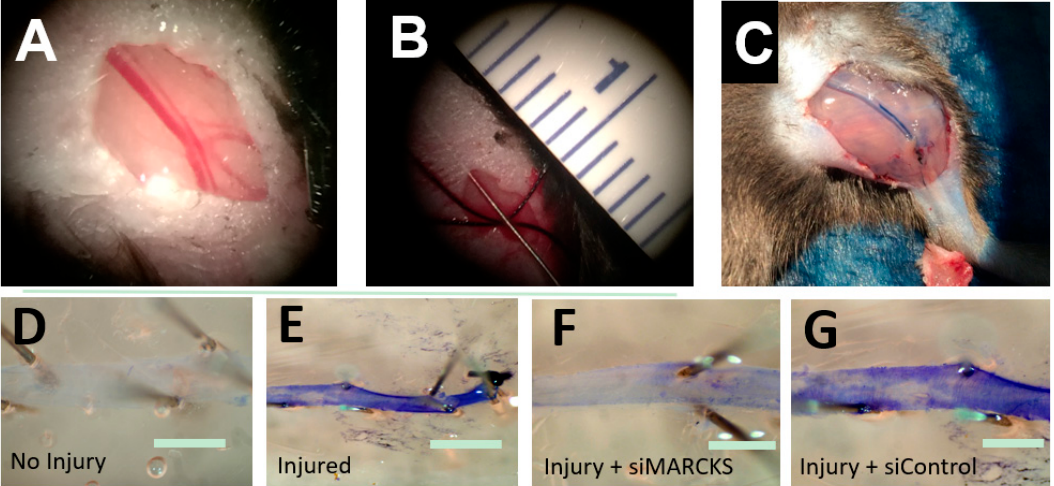
Figure 2. MARCKS knockdown decreases the time to reestablishment of an intact endothelium. ( A ) The mouse femoral artery ( B ) was denuded by passage of a 0.014 inch-diameter wire. ( C ) At the time of euthanasia, the animal was perfused with 0.3% Evans Blue dye which stained the damaged artery. ( D ) A normal, intact endothelium prevents Evans Blue from binding to the basement membrane. ( E ) Damage to the endothelium allows Evans Blue to bind to the vessel. ( F ) Vessels treated with siMARCKS reestablished baseline endothelial function three days after injury. ( G ) Nontargeting siControl exhibited little return of endothelial function at three days (scale bars = 100 μ m).